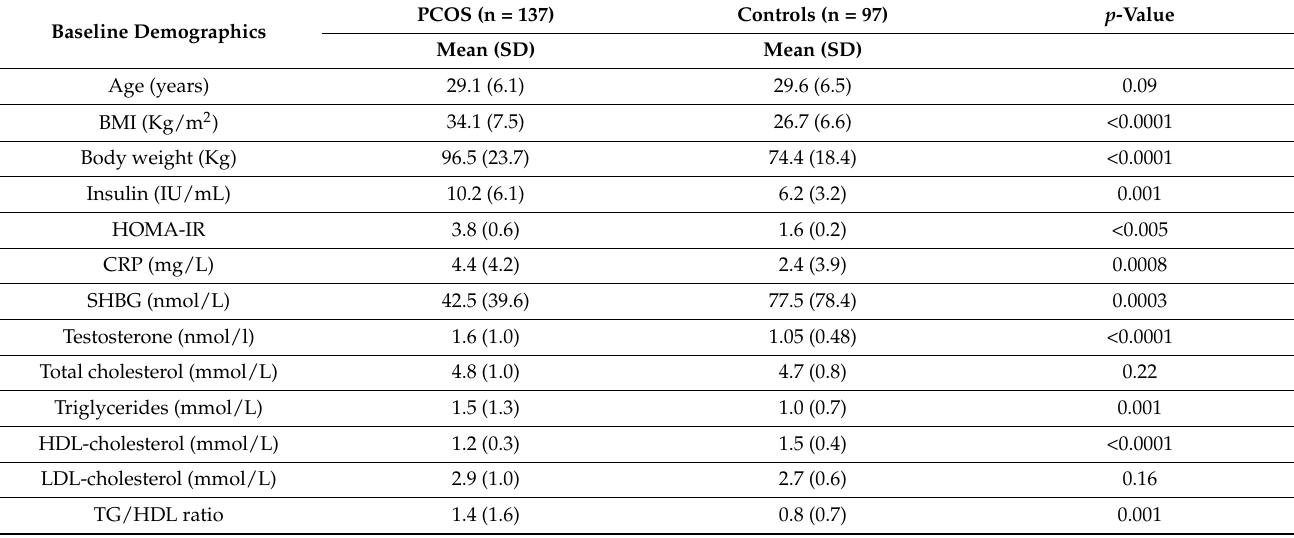
Table 1. Demographics, baseline hormonal, and metabolic parameters of the polycystic ovary syndrome (PCOS) subjects and